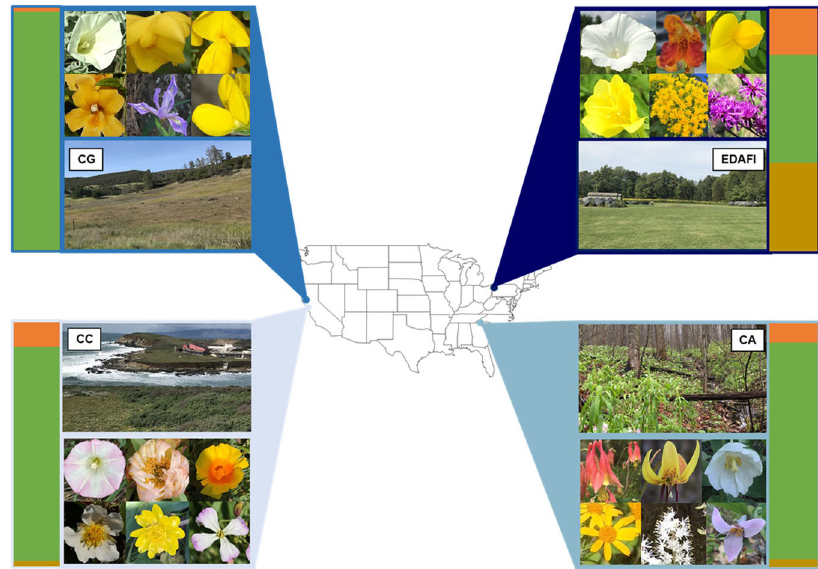
Fig. 1 The four sampling regions and the 24 plant species studied (top left to bottom right). The California Grasslands (CG): Calystegia collina, Calochortus amabilis, Cytisus scoparius, Diplacus aurantiacus, Iris macrosiphon, Thermopsis macrophylla ; The Eastern Deciduous Agroforest Interface (EDAFI): Convolvulus arvensis, Impatiens capensis, Lotus corniculatus, Oenothera biennis, Solidago sp., Vernonia gigantea ; The California Coast (CC): Calystegia